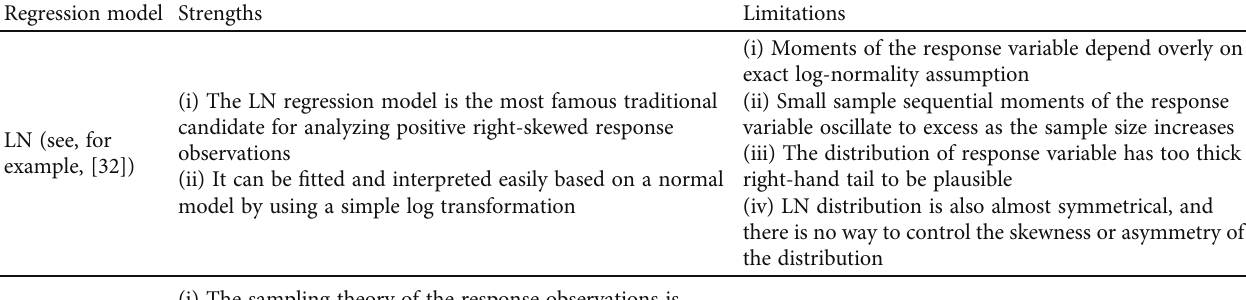
Table 2: A general comparison of strengths and limitations of di ff erent discussed